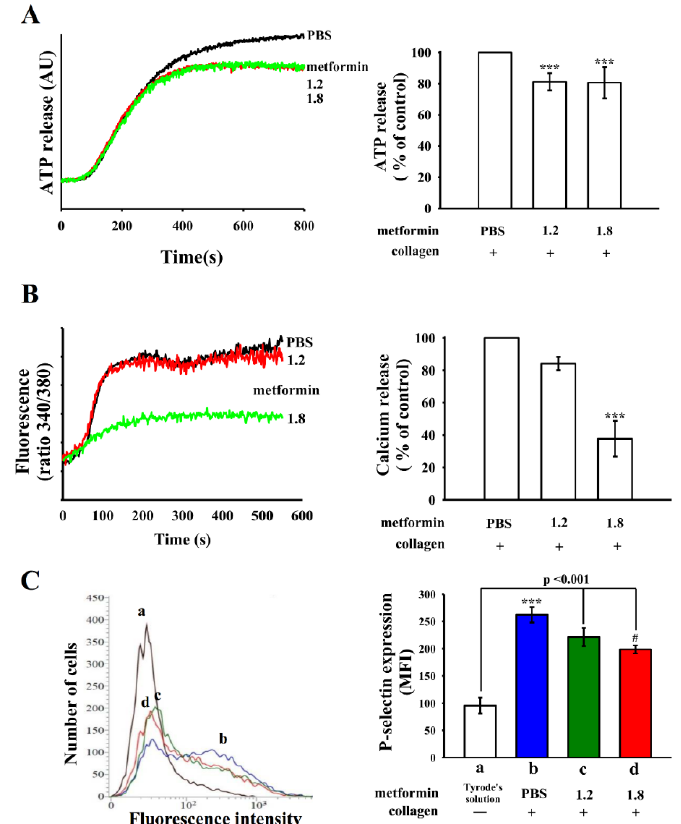
Figure 2. Inhibitory activity of metformin in ATP release, relative [Ca 2+ ]i mobilization, and surface P-selectin expression in human platelets. Washed platelets (3.6 × 10 8 cells/mL) were preincubated with PBS (a solvent control) or metformin (1.2 and 1.8 mM) and treated with collagen (1 µ g/mL) to stimulate ( A ) ATP release (AU: arbitrary unit), ( B ) relative [Ca 2+ ]i mobilization, and ( C ) surface P-selectin expression (MFI: mean fluorescence intensity) (a, Tyrode’s solution; b, collagen-activated; c, metformin 1.2 mM; and d, metformin 1.8 mM); each method is detailed in the Section 2. The respective statistical analyses are shown in the bar diagrams. Results are expressed as mean ± standard error of the mean ( n = 4). *** p < 0.001 vs. PBS + collagen group ( A , B ) or Tyrode’s solution ( C ); # p < 0.05 vs. PBS + collagen group ( C